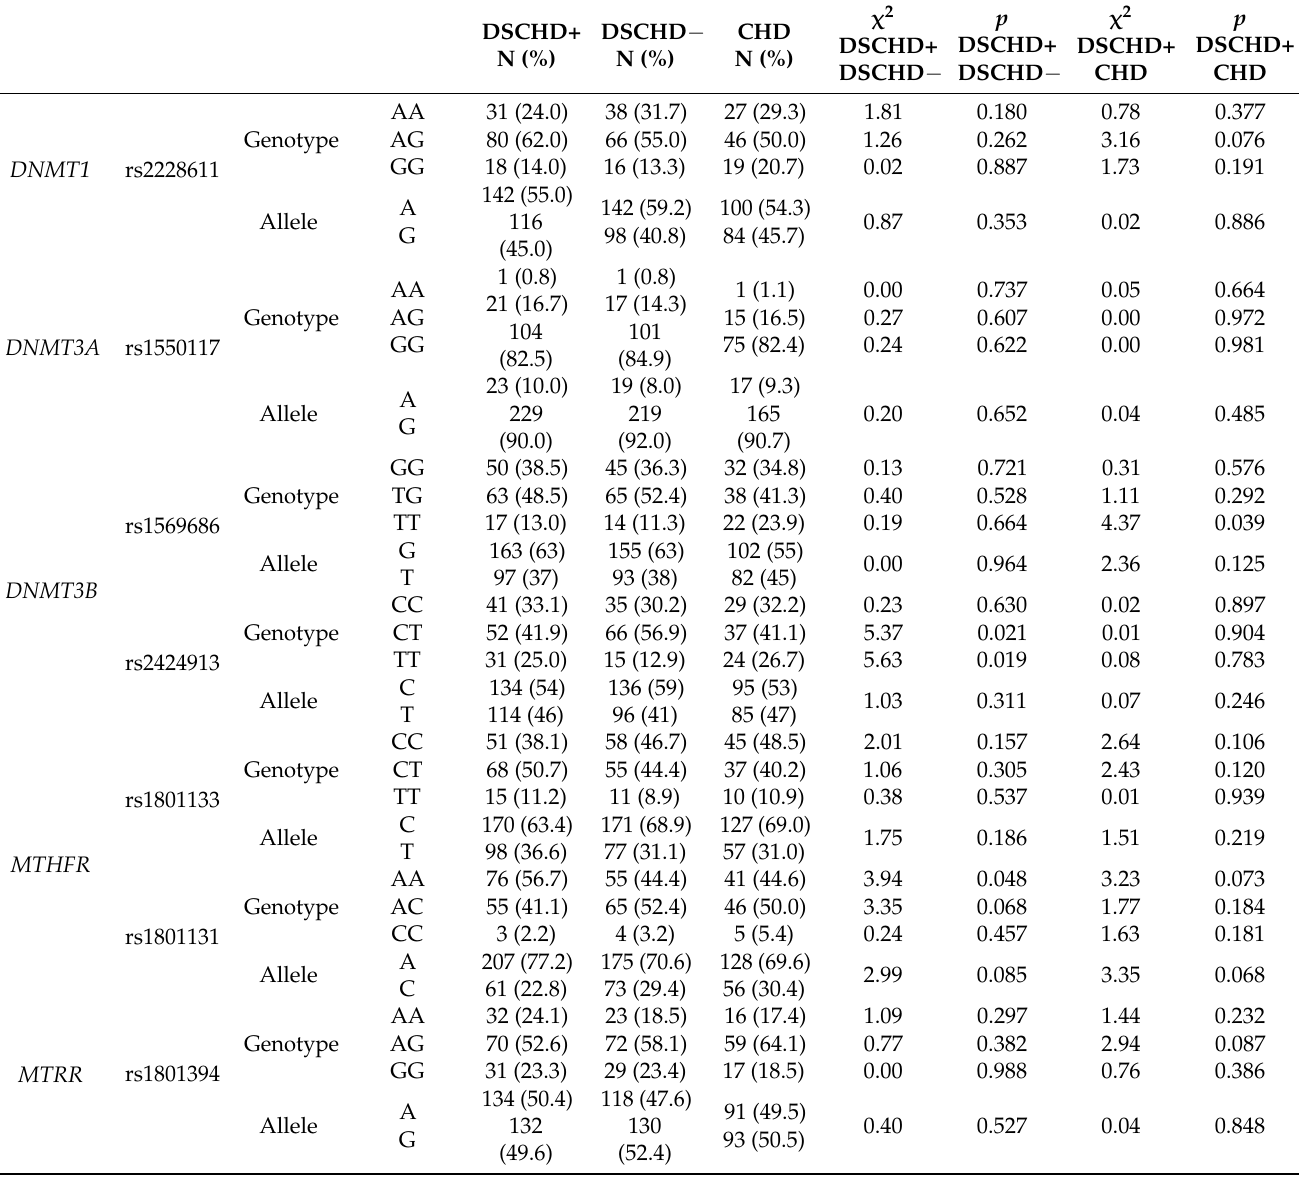
Table 2. Genotype and allele frequencies of DNA methyltransferases ( DNMTs ), methylenetetrahydro- folate reductase ( MTHFR ), and 5-methyltetrahydrofolate-homocysteine methyltransferase reductase ( MTRR ) gene polymorphisms in study